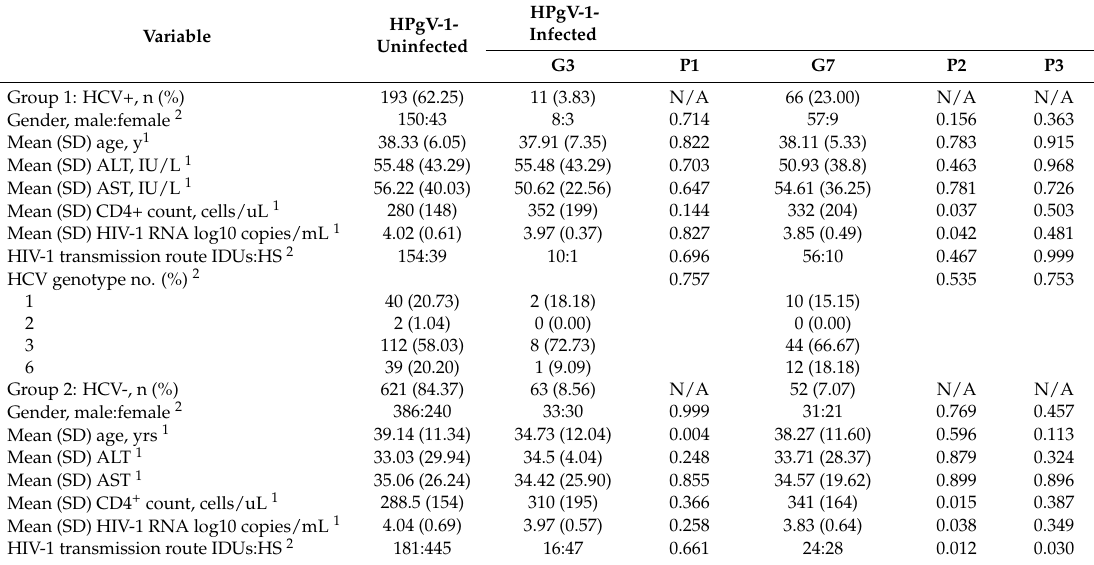
Table 2. Differences between HPgV-1-infected and HPgV-1-uninfected patients among HIV-1-infected individuals with or without